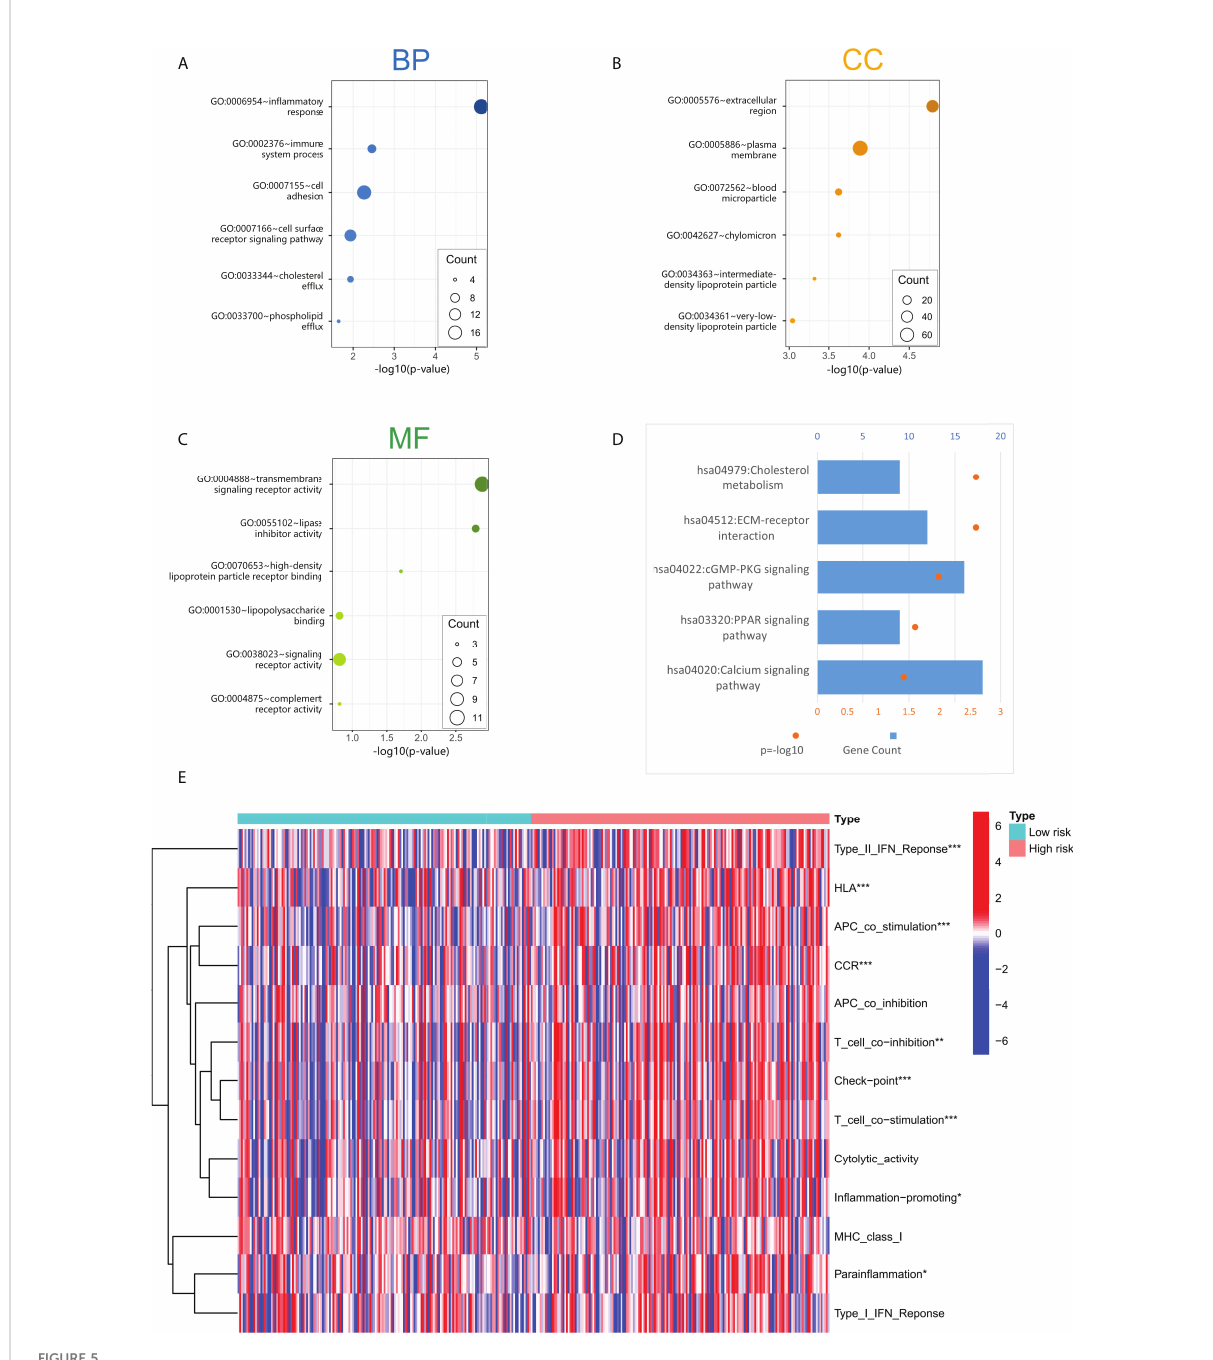
FIGURE 5 (A – C) The screened four lncRNAs related biological process (BP), cellular components (CC), and molecular function (MF). (D) KEGG pathway enrichment analysis offour cuproptosis-related lncRNAs. (E) Immune-related function analysis in high-risk and low-risk groups. "*" represents